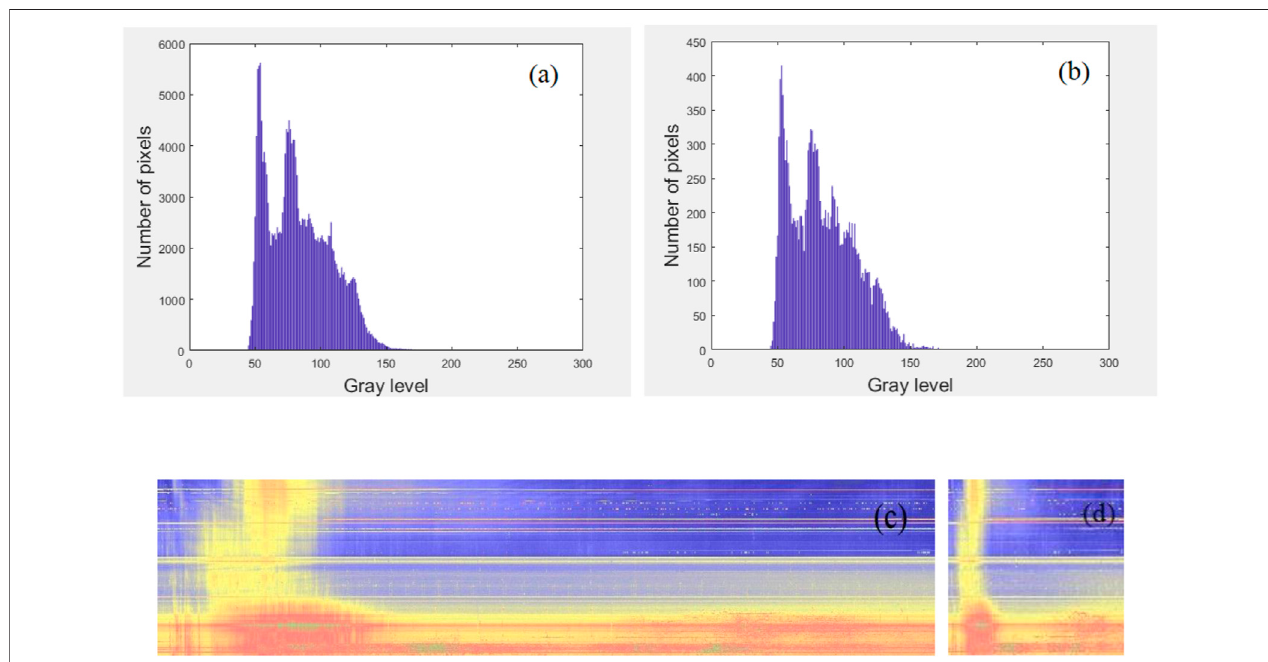
FIGURE 3 | Solar radio spectrograms and histograms before and after downsampling for the event of 2005 August 22 observed by the Learmonth. (A) Histogram before downsampling, (B) histogram after downsampling, (C) original solar radio image, and (D) downsampled solar radio image.